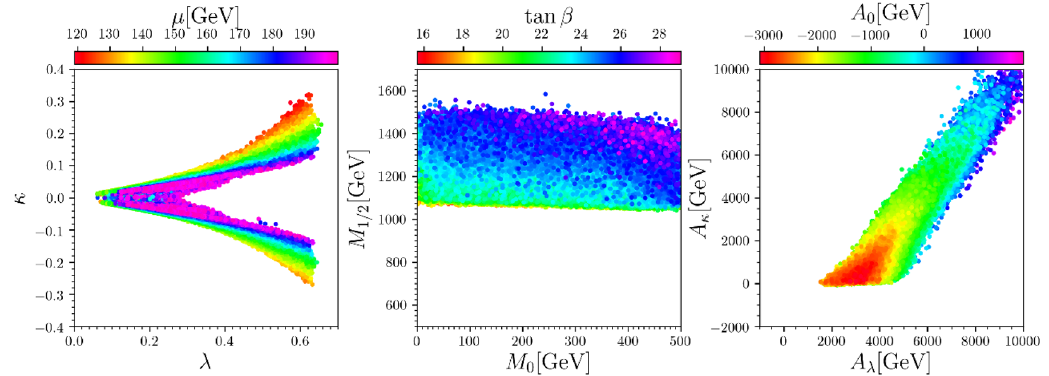
Figure 3 . The (cid:12)nal surviving samples in the (cid:20) versus (cid:21) (left), M A (cid:21) (right) planes. From left to the right, colors indicate the (cid:22) , tan (cid:12) and A 0 ,